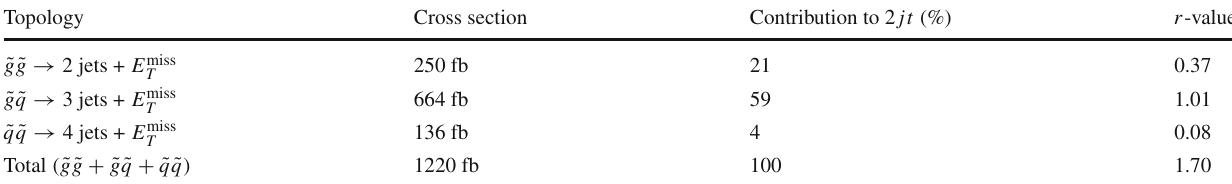
Table 5 Contributions of specific signal topologies to the total exclu- sion for the pMSSM point no. 192342466. The second column shows the topology cross section (production cross section times branching ratios), while the third column shows the topology contribution to the signal yield for the 2 jt signal region of Ref. [35]. The last column Topology Cross